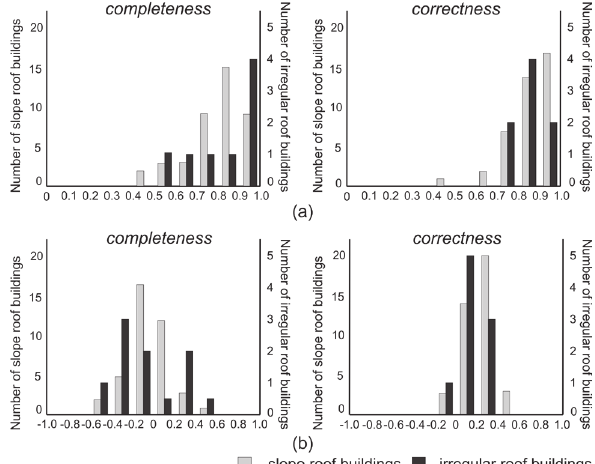
Figure 6. Area based assessment (a) compared with cadastral map and (b) improvement from previous